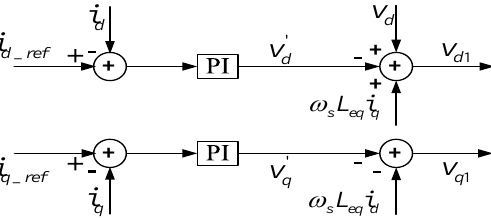
Figure 2. Conventional decoupled vector control for simplified single-phase GCC with the L filter, the LC filter or the LCL filter.